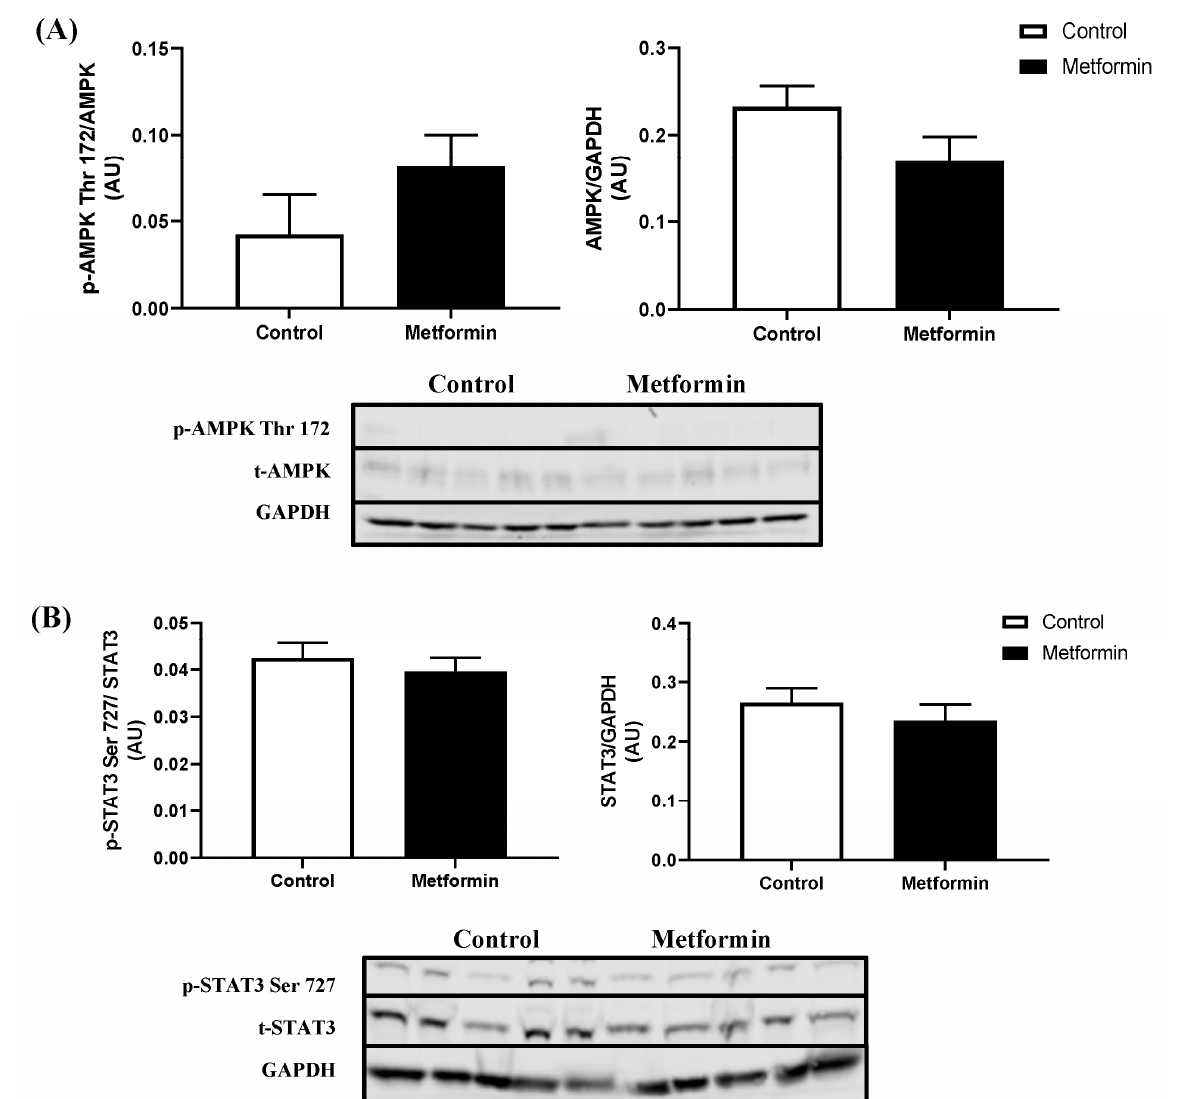
Figure 4. STAT3 and AMPK expression in Lewis lung carcinoma cells treated with 10 mM Met- formin. ( A ) Phospho (p)- Signal transducer and activator of transcription 3 (STAT3) Ser727/Total STAT3 and STAT3/GAPDH expression (arbitrary units, AU) in LL/2 cells treated with or without 10 mM metformin. Data were analyzed using an unpaired t-test. Sample size: n = 5. Data are mean ± SEM. ( B ) Phospho (p)- adenosine monophosphate-activated protein kinase (AMPK) Thr172/Total AMPK and AMPK/GAPDH expression (arbitrary units, AU) in LL/2 cells treated with or without 10 mM metformin. Data were analyzed using an unpaired t -test. Sample size: n = 5. Data are mean ± SEM.